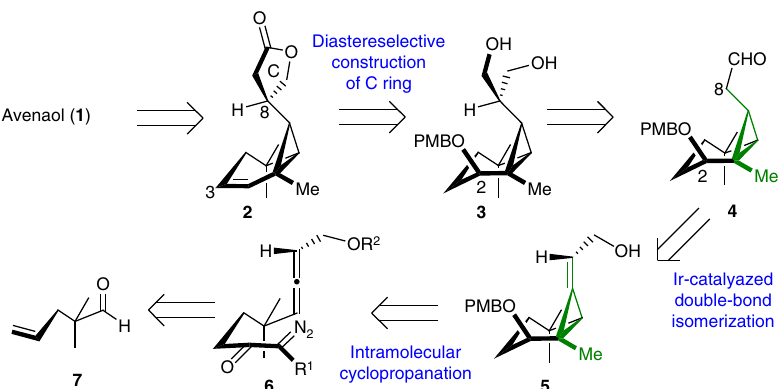
Fig. 2 Retrosynthesis of avenaol ( 1 ). Our strategy is characterised by the use of an alkylidenecyclopropane intermediate 5 , providing a robust route to the required all- cis -substituted cyclopropane, while avoiding the undesired ring opening of the cyclopropane ring and the formation of a caged structure. The numbering of the carbon atoms is consistent with that used for avenaol. PMB p -methoxybenzyl